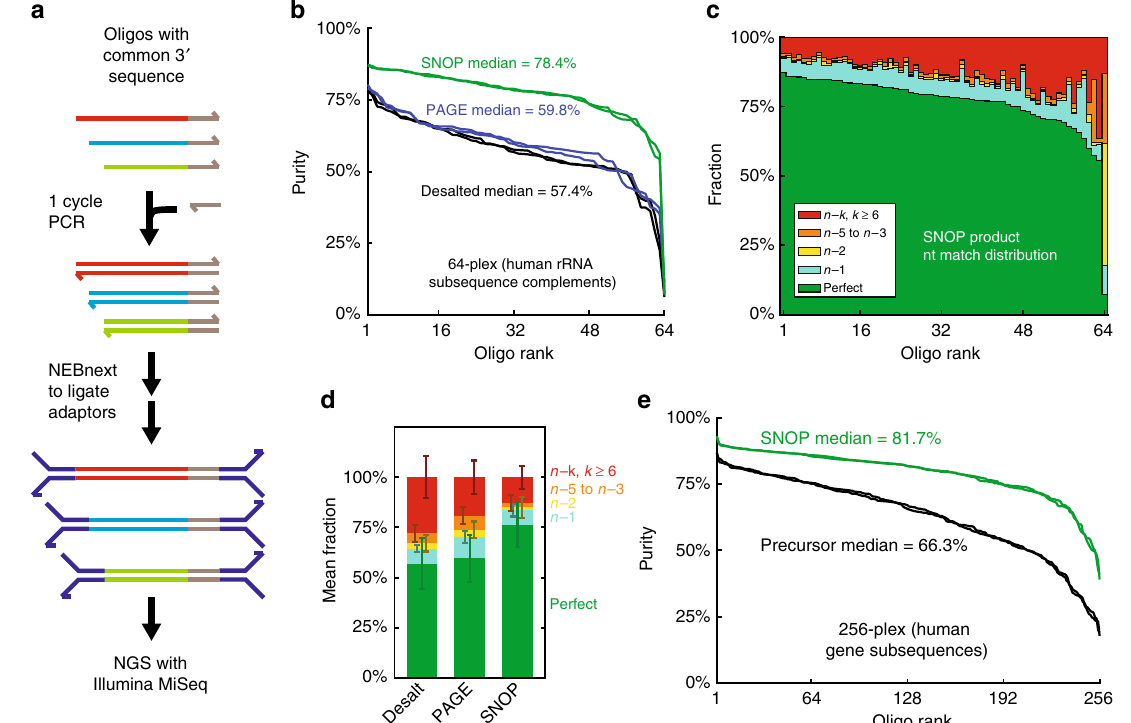
Fig. 4 Characterization of high-plex SNOP product purities using next-generation sequencing (NGS). a To minimize the ligation and sequencing bias of library preparation and sequencing steps, the oligos used for this set of experiments all possess a common 3 ′ sequence. Using the complement of the common 3 ′ sequence as a PCR primer generates double-stranded product oligos. Afterwards, Illumina sequencing adaptors and P5/P7 sequences are appended using the NEBnext kit. In all NGS experiments, overlapped paired-end sequencing was performed, and any sequence in which the forward and reverse reads do not perfectly agree were discarded bioinformatically, in order to minimize the effects of NGS intrinsic error. b Distribution of purities observed for oligo products of a 64-plex SNOP; here, oligo products were all 70 nt long. Purity is here de fi ned as the number of NGS reads that perfectly match the designed oligo sequence, divided by the number of NGS reads that align to the designed oligo sequence via Bowtie 2 29 . The purity distributions for two replicate libraries are plotted. SNOP products exhibit signi fi cantly higher purities than commercial oligos individually puri fi ed via PAGE; median purity values are displayed in the fi gure. c Summary of NGS reads aligned to each oligo, by the number of nucleotides matched to the designed sequence. For most oligos, the three most dominant classes of reads are Perfect (green), single-base truncations or deletions (cyan), or gross (6 + ) errors. d Summary of NGS reads analysis for the desalted, PAGE, and SNOP libraries. N = 64 precursor oligonucleotides; error bars show standard deviation across different oligos. e Distribution of purities observed for 256-plex SNOP products, as compared to commercial desalted